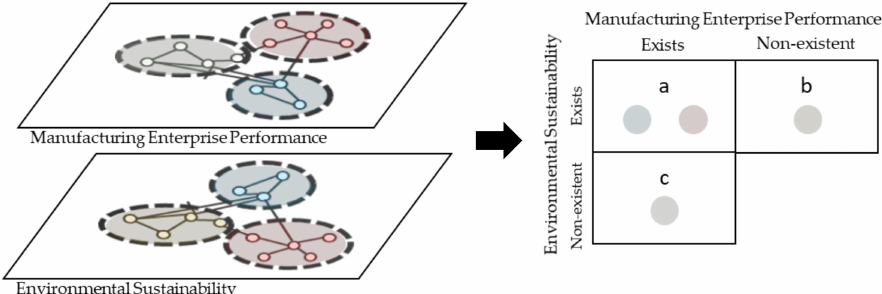
Figure 2. Identifying linkages between two topics of interest. Clusters sharing similar semantic con- tent signal the presence of shared topics (quadrant “a”), while the remaining clusters are distinctive topics (quadrants “b” and